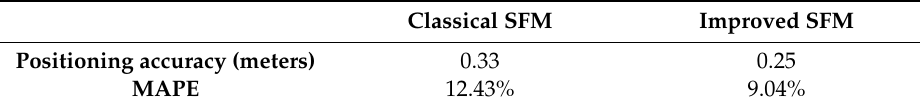
Table 2. Accuracy of simulation results using the social force